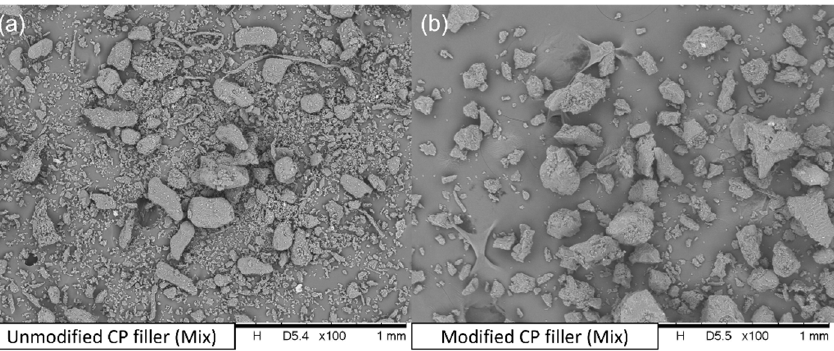
Figure 3. SEM pictures of ( a ) unmodified CP filler; ( b ) modified CP filler.